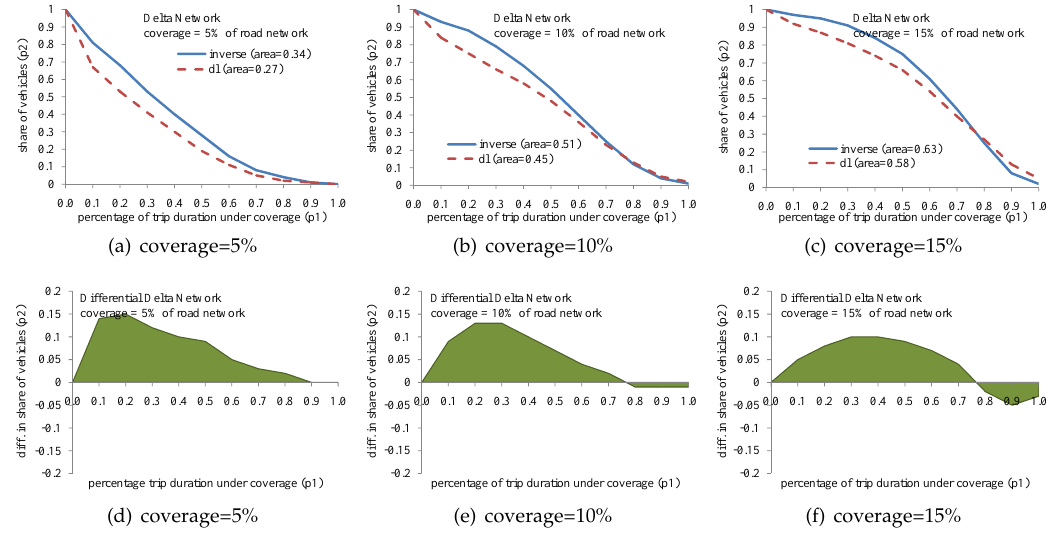
Figure 10. Strategy dl deploys roadside units at the most popular locations (red color), while inverse assumes a distribution of weights inversely proportional to ρ 1 (color blue). The y -axis indicates the share of vehicles ( ρ 2 ), while the x -axis indicates percentage of trip under coverage ( ρ 1 ). ( a – c ) Consider coverage ranging from 5% up to 15% of the road network. ( d – f ) Represent “ inverse minus dl ”.